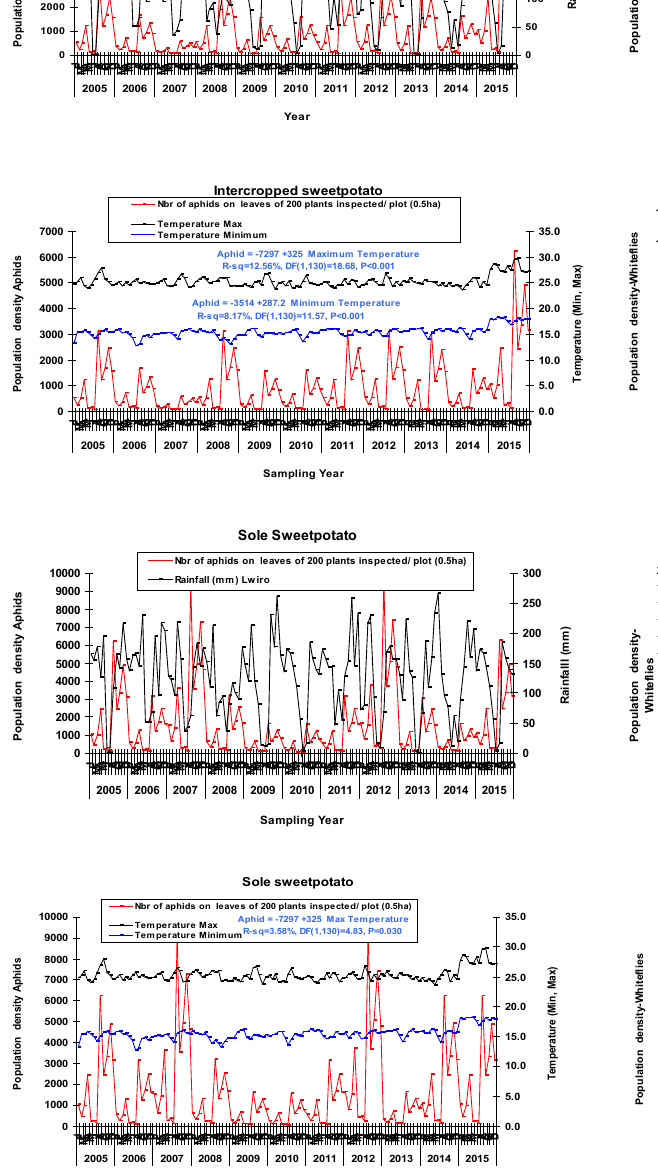
Figure 7: Fluctuation of the population density of whiteflies (Bemisia tabaci) in relationship with variability in climatic factors (rainfall, temperature) under intercropping and mono-cropping systems